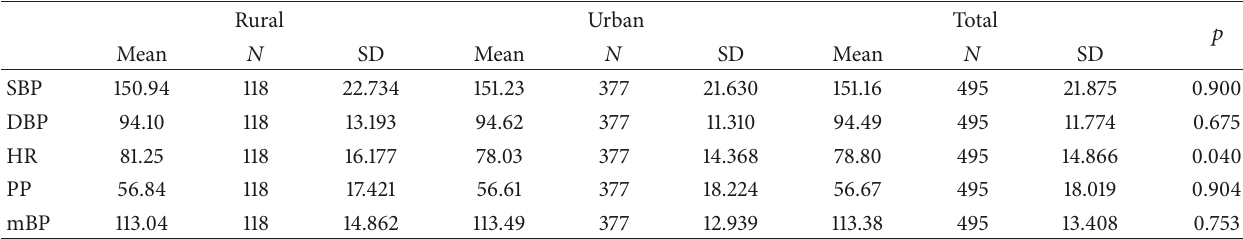
Table 4: Blood pressure related parameters in the sample of 495 hypertensive